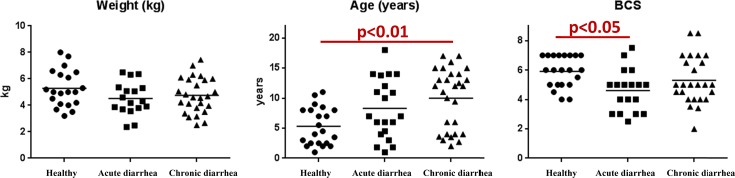
Body weight, age, and Body Condition Score (BCS) in evaluated cats.